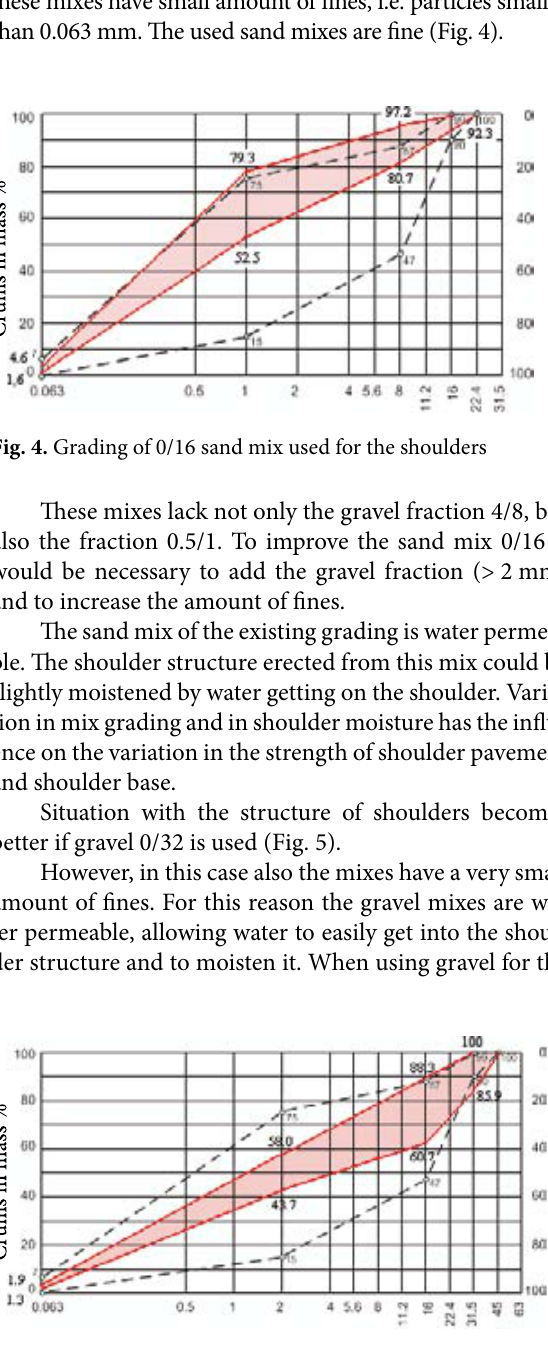
fig. 5. Grading of 0/32 gravel mix used for the